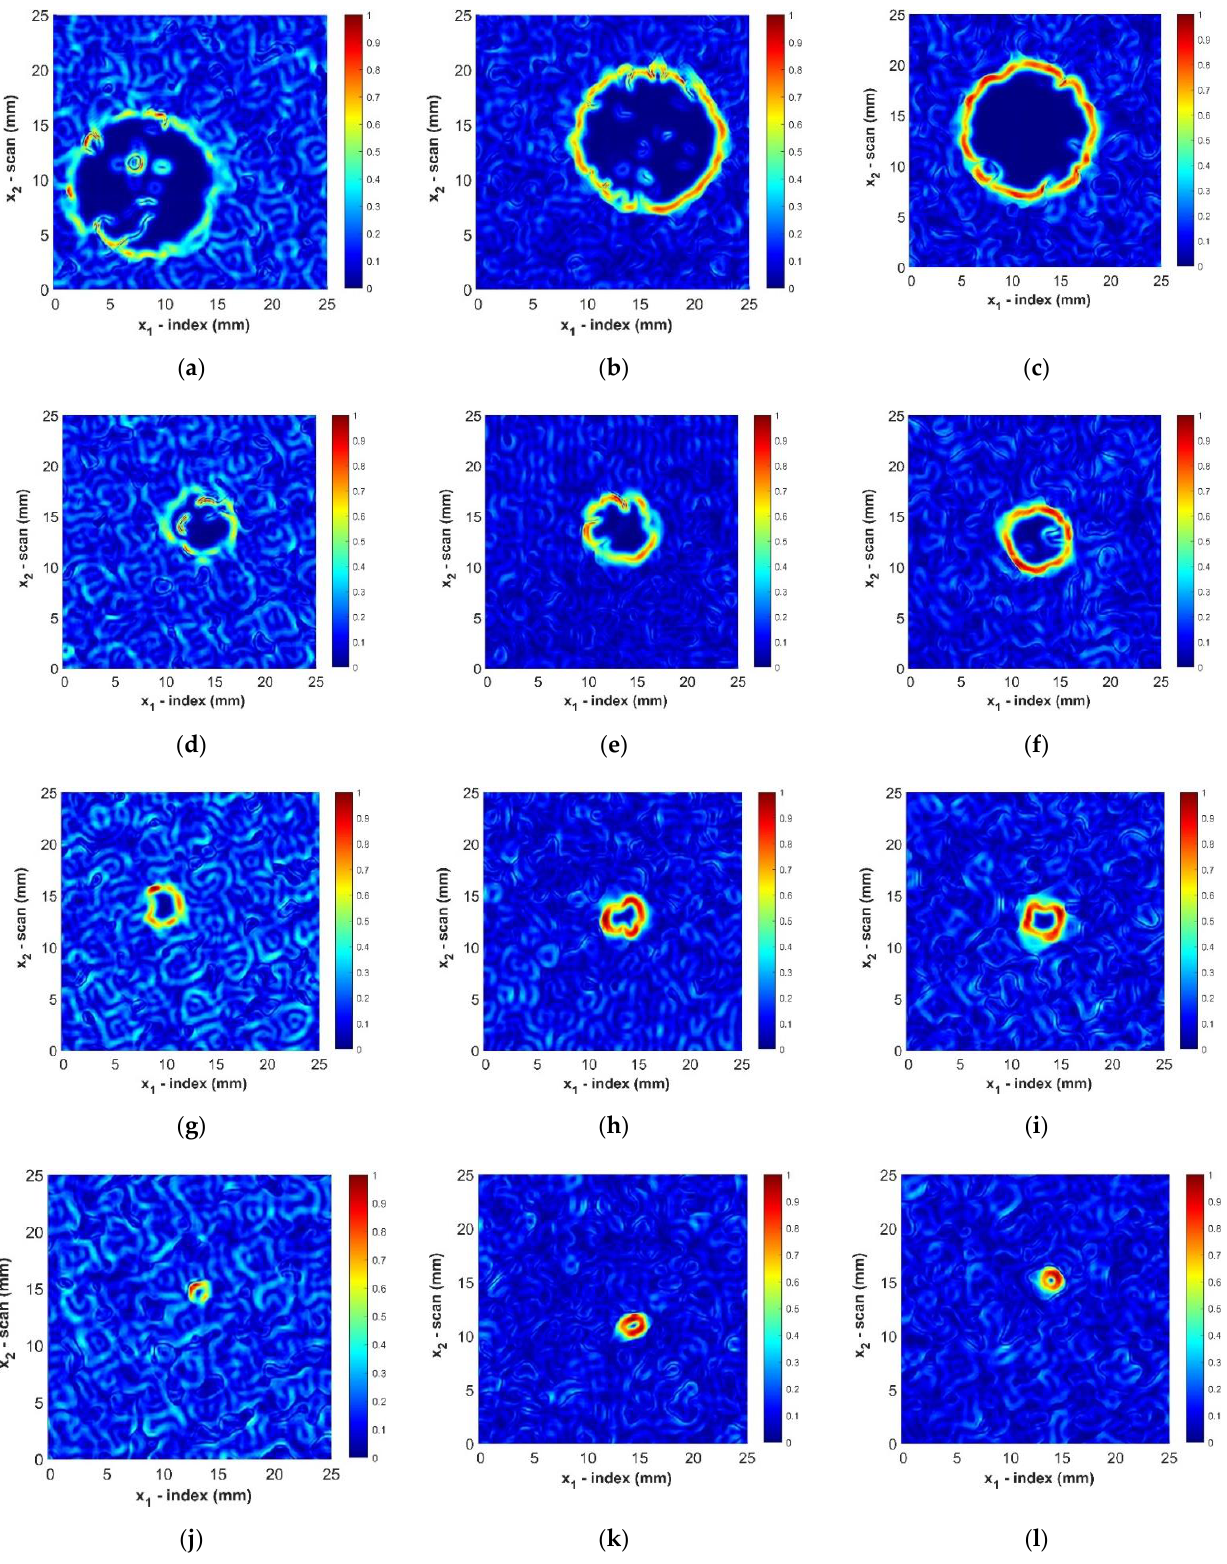
Figure 11. Magnitude of the gradient applied to determine edge of foreign objects, where the color represents the normalized intensity of the gradient: ( a ) Sample A1; ( b ) Sample A2; ( c ) Sample A3; ( d ) Sample B1; ( e ) Sample B2; ( f ) Sample B3; ( g ) Sample C1; ( h ) Sample C2; ( i ) Sample C3; ( j ) Sample D1; ( k ) Sample D2; ( l ) Sample D3.